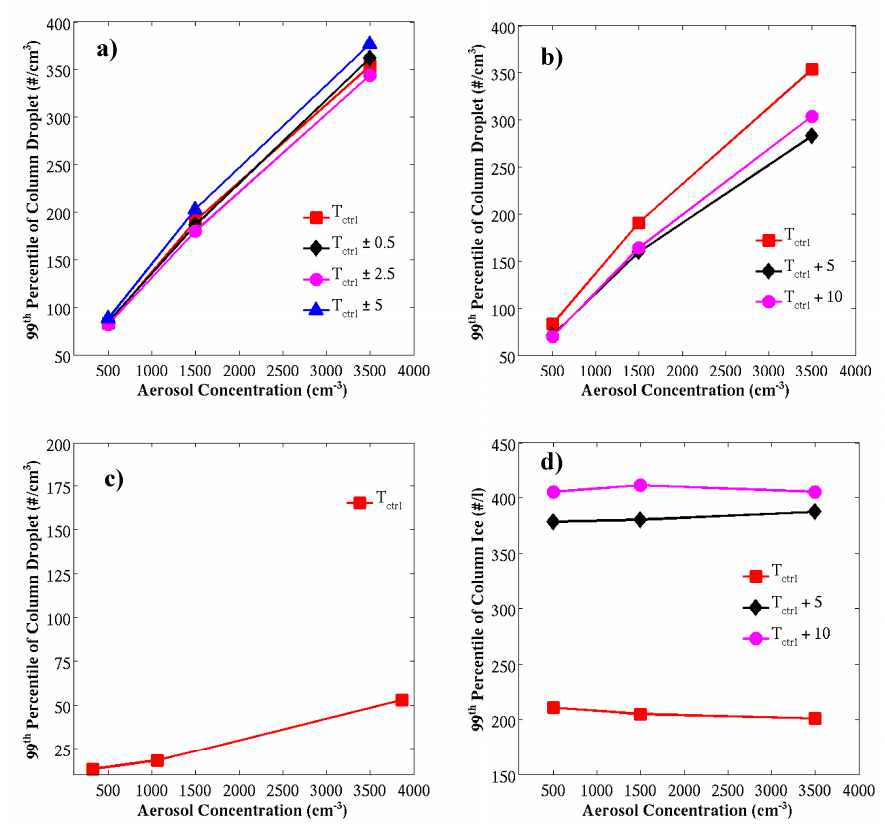
Figure 2. Correlation between cloud droplet number concentration (CDNC) and aerosol concentrations simulated for ( a ) random temperature perturbations; ( b ) uniform temperature perturbations; and ( c ) prognostic CCN scenarios; ( d ) Correlation between ice number concentration and aerosol concentration simulated for uniform temperature perturbations.